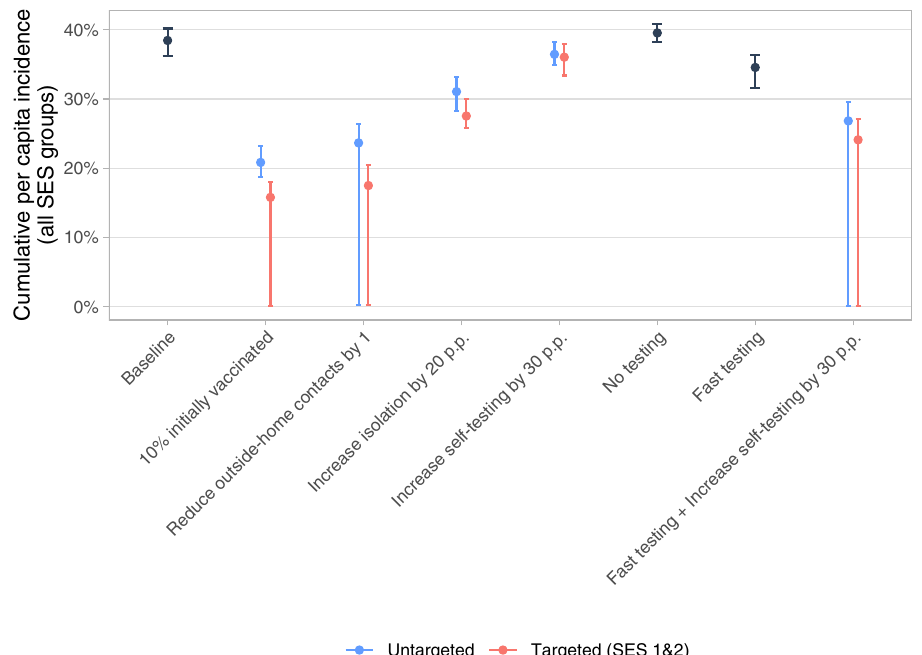
Figure 5. Policy-style scenarios. In “Untargeted” scenarios, policy adjustments affect all groups equally. In “Targeted” scenarios, only the parameters of SES 1&2 are adjusted, but adjustments in this group are greater, such that the mean adjustment across the whole population is the same as in the untargeted scenario. “10% initially vaccinated”: 10% of the population are immune to the virus from the start of the epidemic. “Reduce outside-home contacts by 1”: mean reduction of 1 in contacts outside the home. “Increase isolation by 20 p.p.”: mean increase of 20 percentage points in probability of isolating conditional on being symptomatic and being contact traced. “Increase self-testing by 30 p.p.”: mean increase of 30 percentage points in the probability of being tested after observing symptoms. “No testing”: probability of self-testing and of being contact traced are set to 0. “Fast testing”: all tests have a consultation delay and a results delay of 1 day. Outcome variable is the median cumulative per capita incidence across all SES for 50 simulated epidemics with no mobility change. Error bars indicate the 0.025 and 0.975 quantiles of the 50